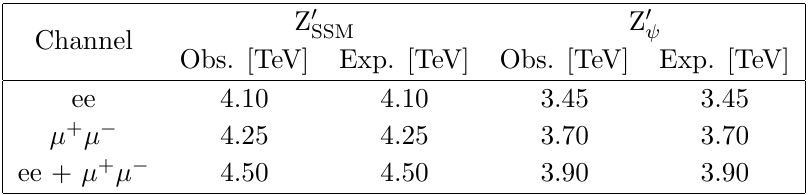
and Z 0 SSM ). SSM